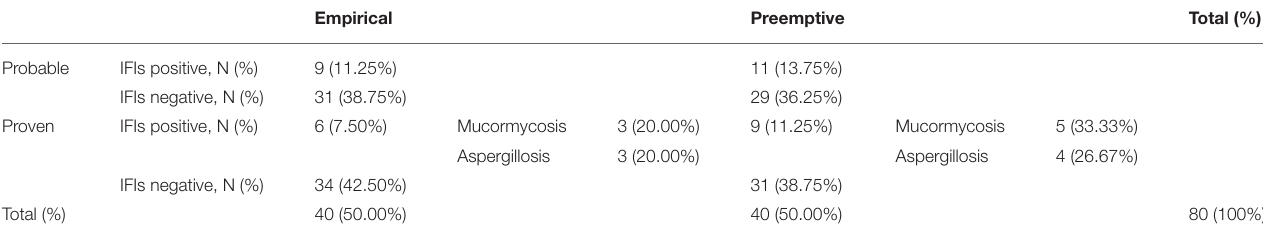
TABLE 2 | Frequency of proven/probable fungal infections with regard to type of